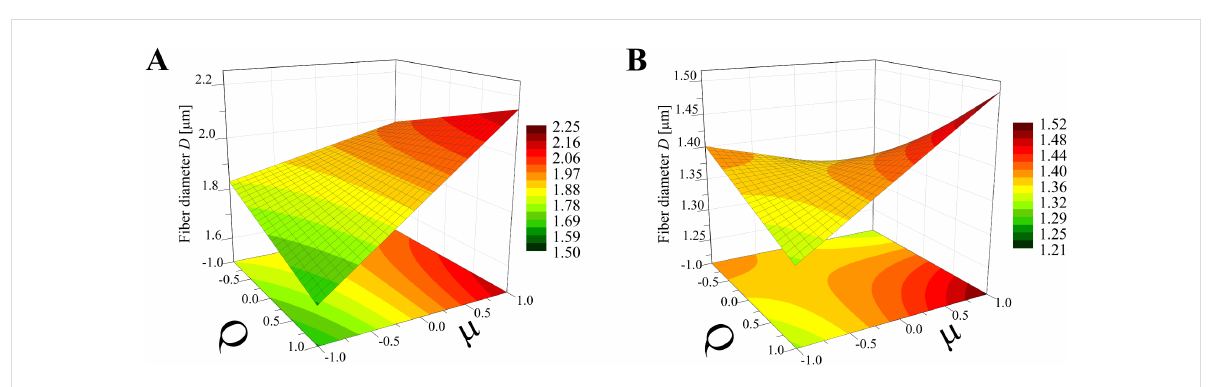
Figure 7: Response surface plots presenting the dependence of the diameter of the obtained bead-free fibers ( D ) on the dynamic viscosity (µ) and the flow rate ( Q ) of the polymer solution for the (A) minimum electrical voltage ( U = − 1) and (B) maximum electrical voltage ( U = +1).